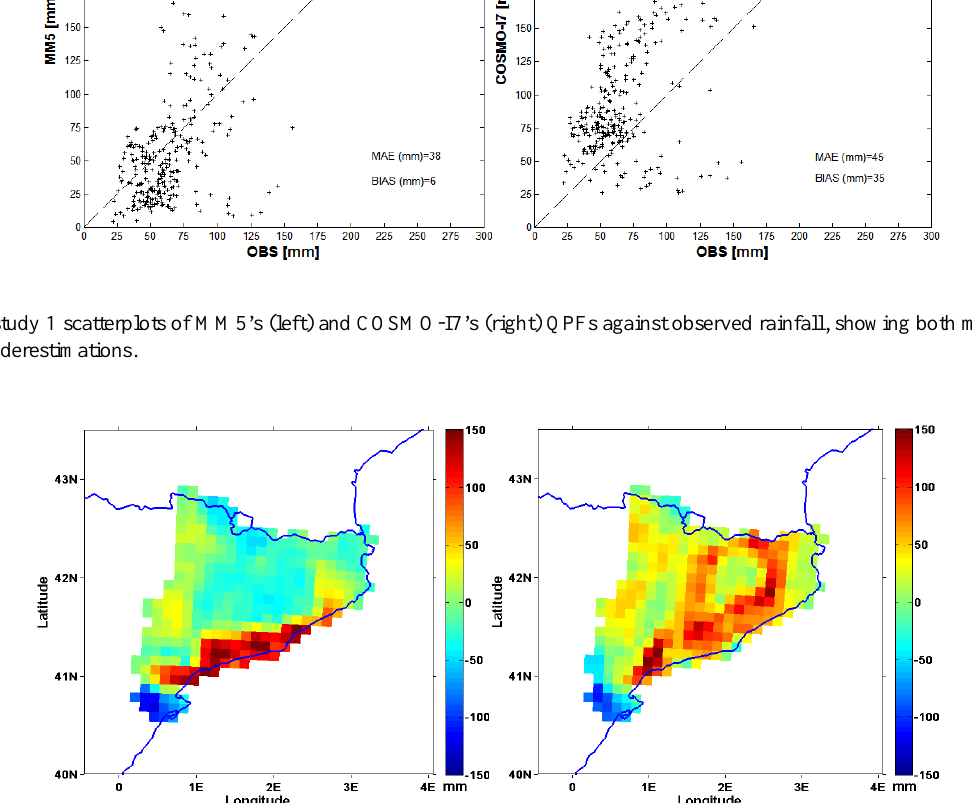
Fig. 15. Rainfall prediction bias fields over Catalonia for MM5’s (left) and COSMO-I7’s (right) QPFs for case study Figure 15. Rainfall prediction bias fields over Catalonia for MM5‟s (left) and COSMO- 3 I7‟s (right) QPFs for case study 1. 4